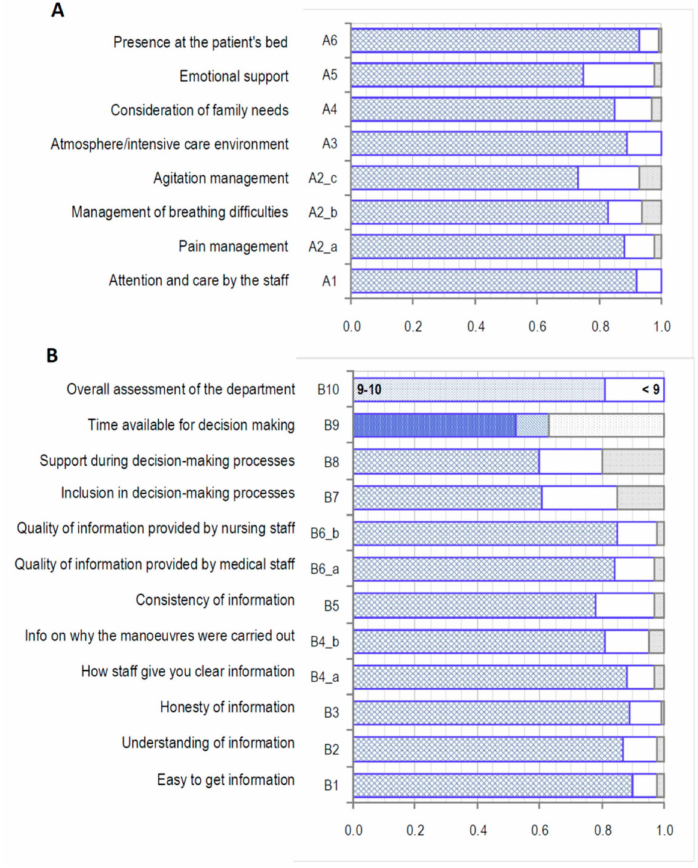
Figure 1. Answers obtained to each question of the questionnaire. ( A ) first part of the questionnaire; ( B ) second part of the